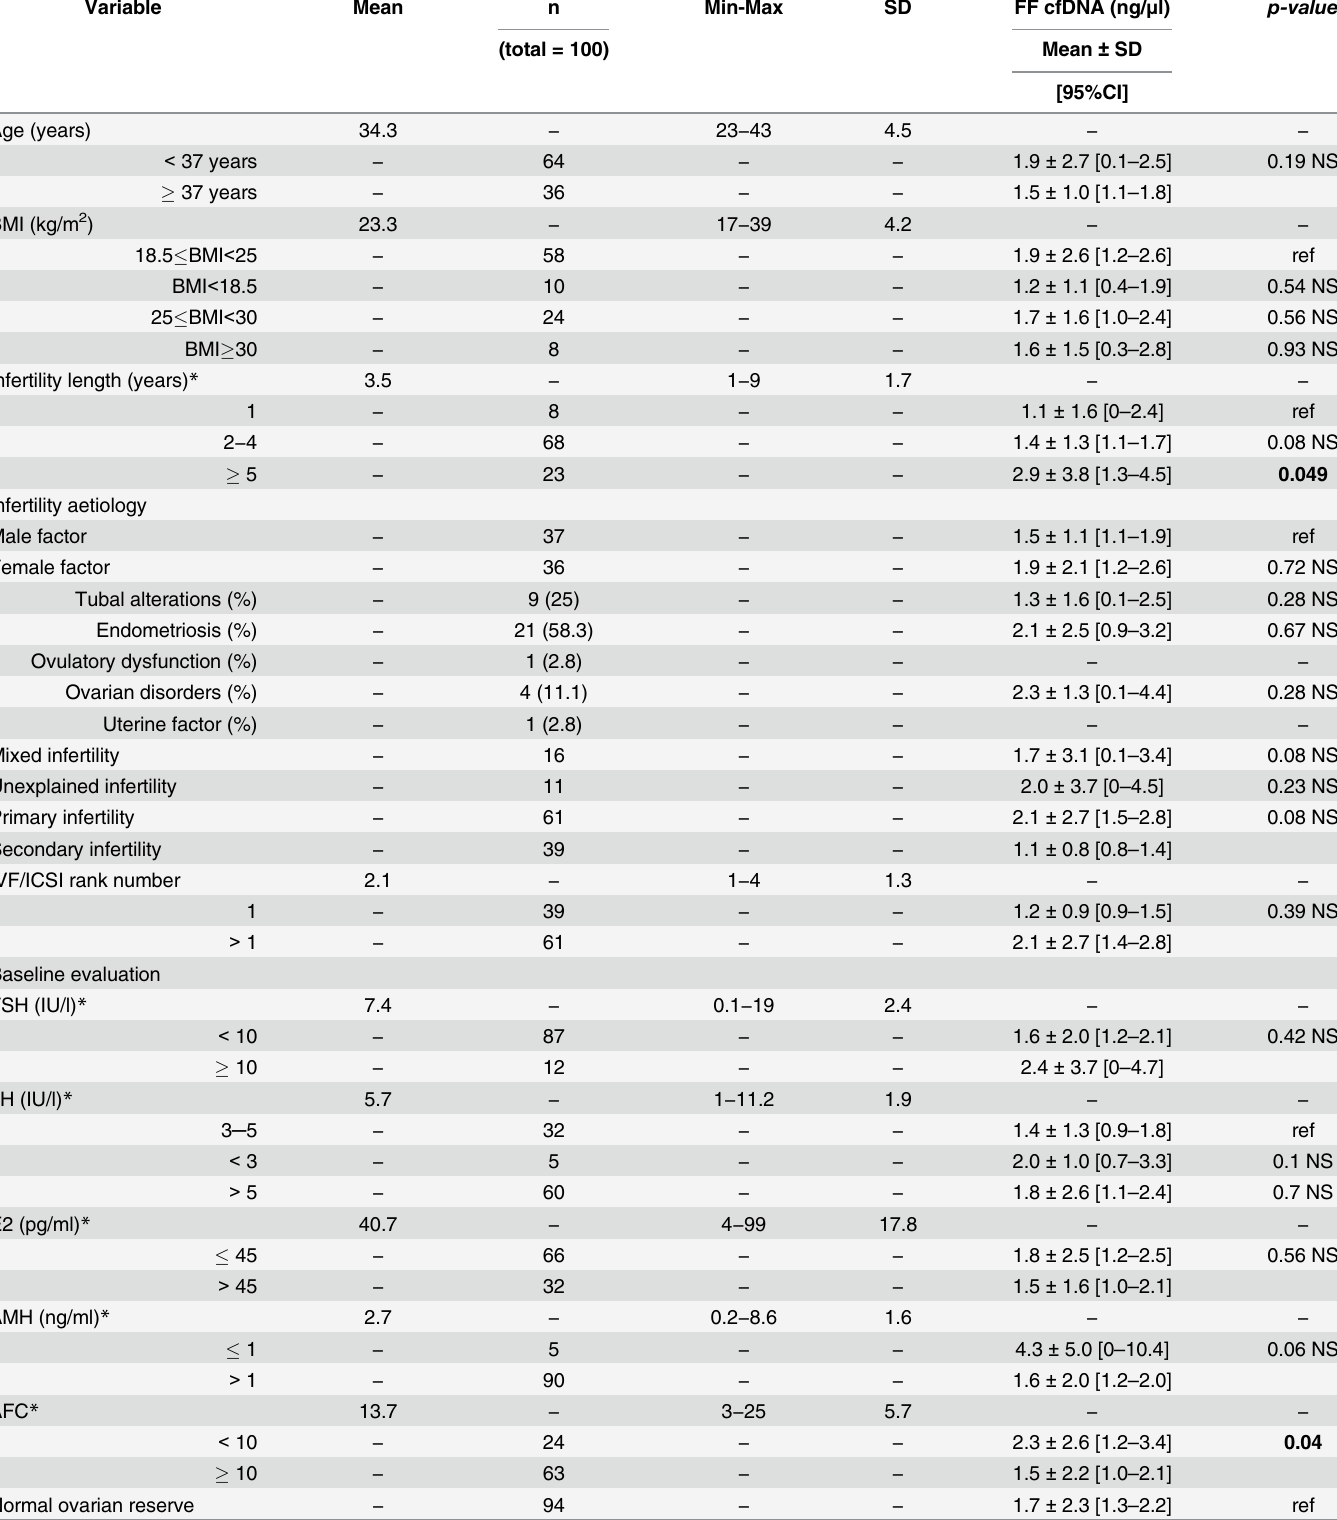
Table 1. Cell-free DNA level in follicular fluid pools according to the patients ’ clinical